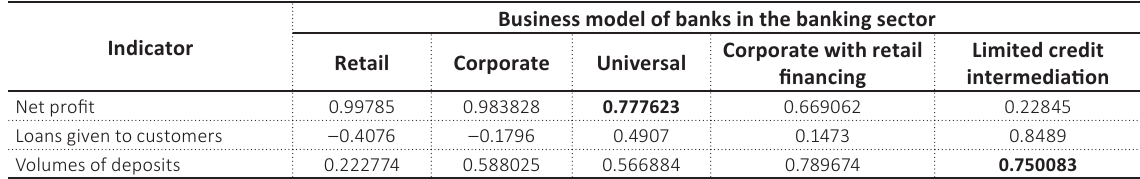
Table 2. Correlation coefficients of indicators of Ukraine’s banking sector with the contribution of certain groups of banks by business model type to their formation in 2015–2020 Source: Calculated by the authors based on the National Bank of Ukraine